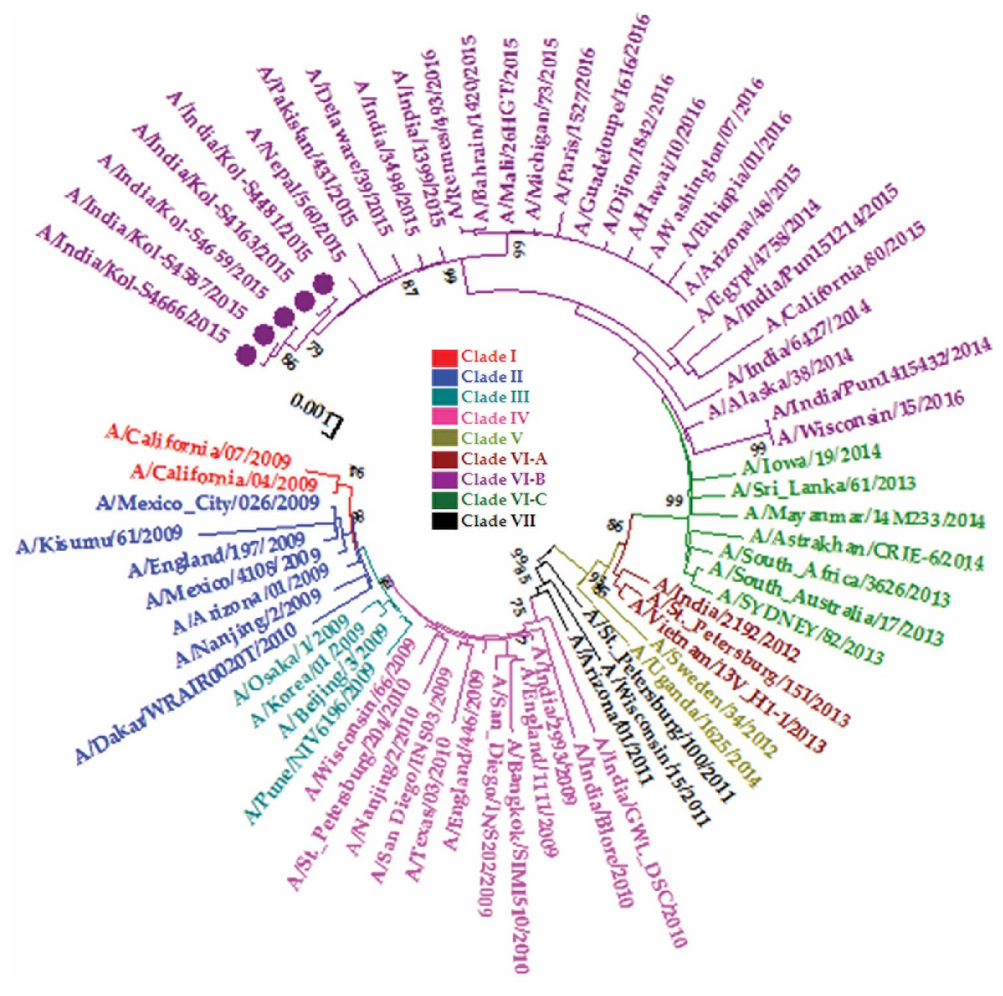
Fig 1. Phylogenetic tree of concatenated whole genomes of 2015 A(H1N1)pdm09 isolates of Kolkata, India and representative global isolates from different clades. The strains characterized in this study are designated with purplecircle. The globalinfluenza A A(H1N1)pdm09 virus clades are indicatedin different